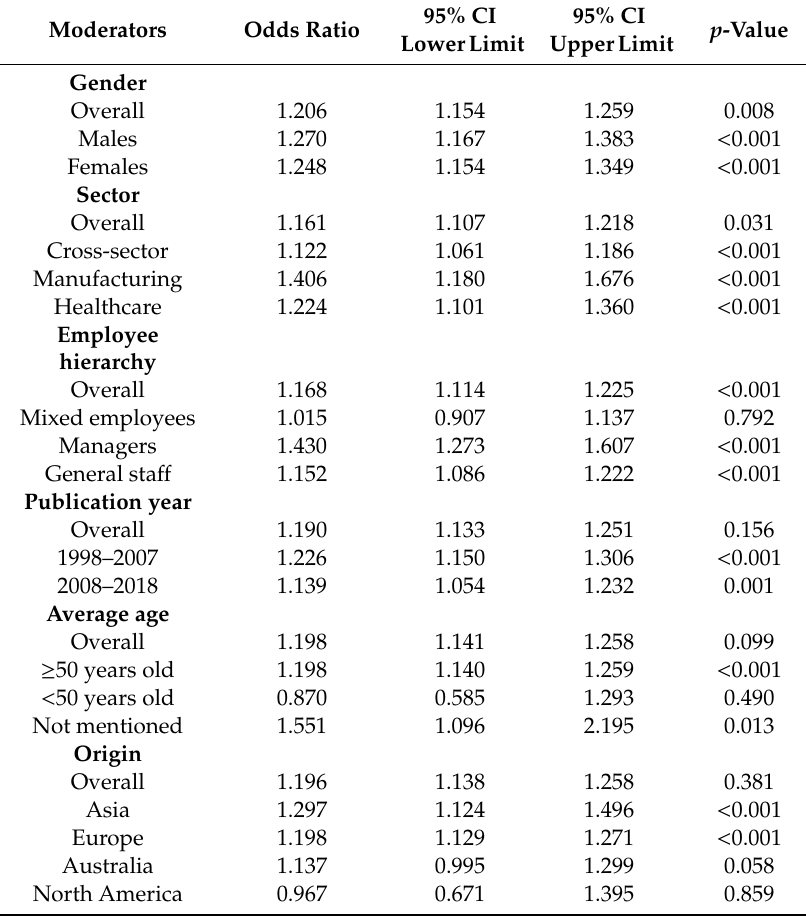
Table 3. Results of the moderators using a subgroup